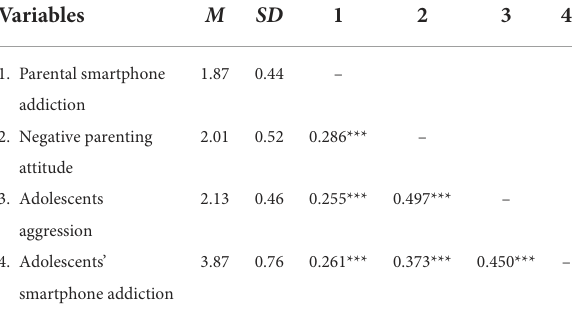
TABLE 2 Descriptive statistics and correlations between main variables.